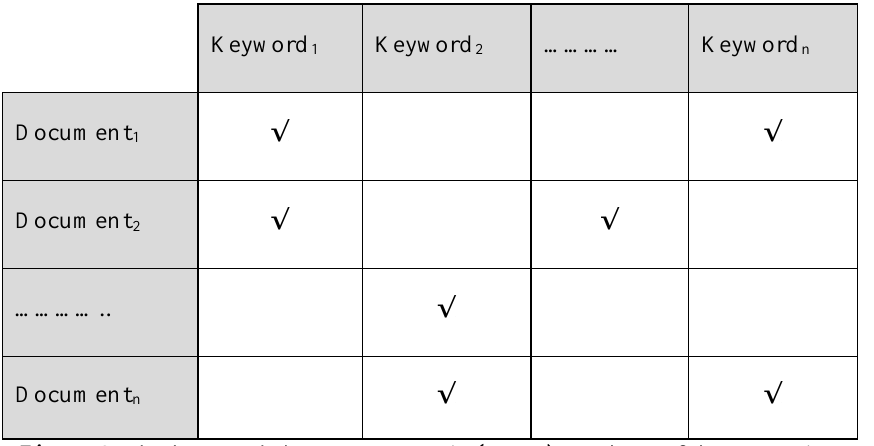
Figure 3 . The keyword-document matrix (KDM ) , a subset of the TDM, is created for the OERScout system by matching the autonomously identified keywords against the documents.